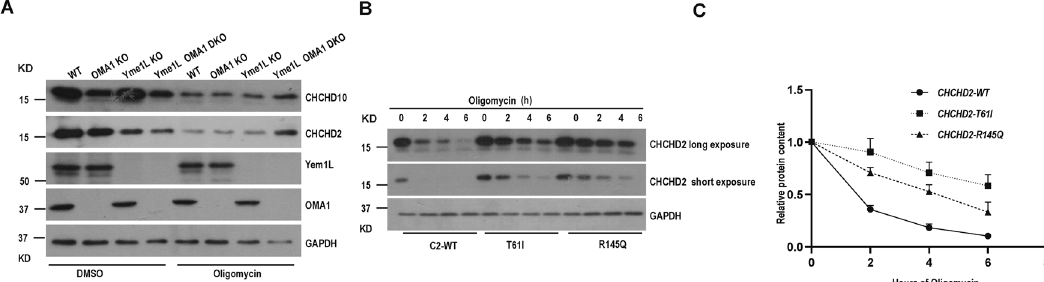
Fig. 6 Yme1L and OMA1 are responsible for degrading CHCHD2 and CHCHD10. A Immunoblot of OMA1 KO, Yme1L KO, OMA1 Yme1L DKO, and WT HeLa cells treated with dimethyl sulfoxide (DMSO) or 10 μ m Oligomycin for 8 h. GAPDH served as loading controls. B Immunoblot of WT and CHCHD2 KO HeLa cell lines which stably express CHCHD2 WT, T61I or R145Q mutation where indicated, treated with either vehicle or 125 μ m Oligomycin for 6 h. GAPDH served as the loading control. C Quanti fi cation of levels CHCHD2 and its mutation CHCHD2-T61I and CHCHD2-R145Q from B. The relative protein levels were evaluated by densitometry analysis using ImageJ software and were quanti fi ed for the ratio of CHCHD2/GAPDH, T61I /GAPDH, and R145Q/GAPDH ( n = 3 independent experiments). The data are presented as mean ±